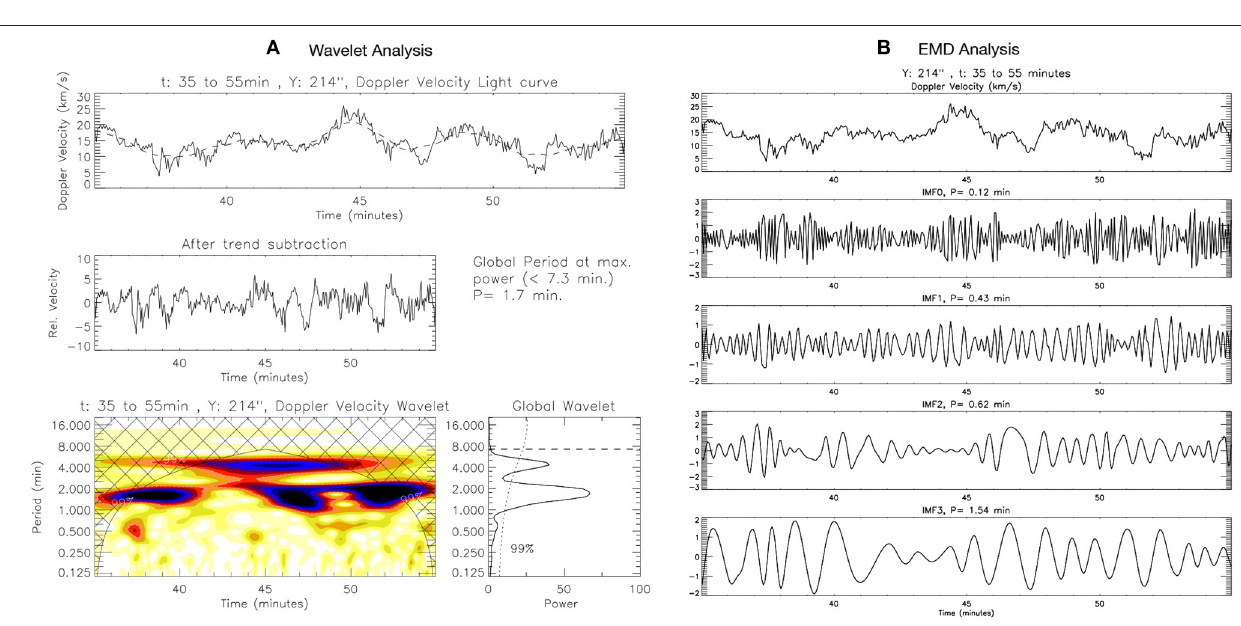
FIGURE 6 | Same as Figure 5 but for Doppler